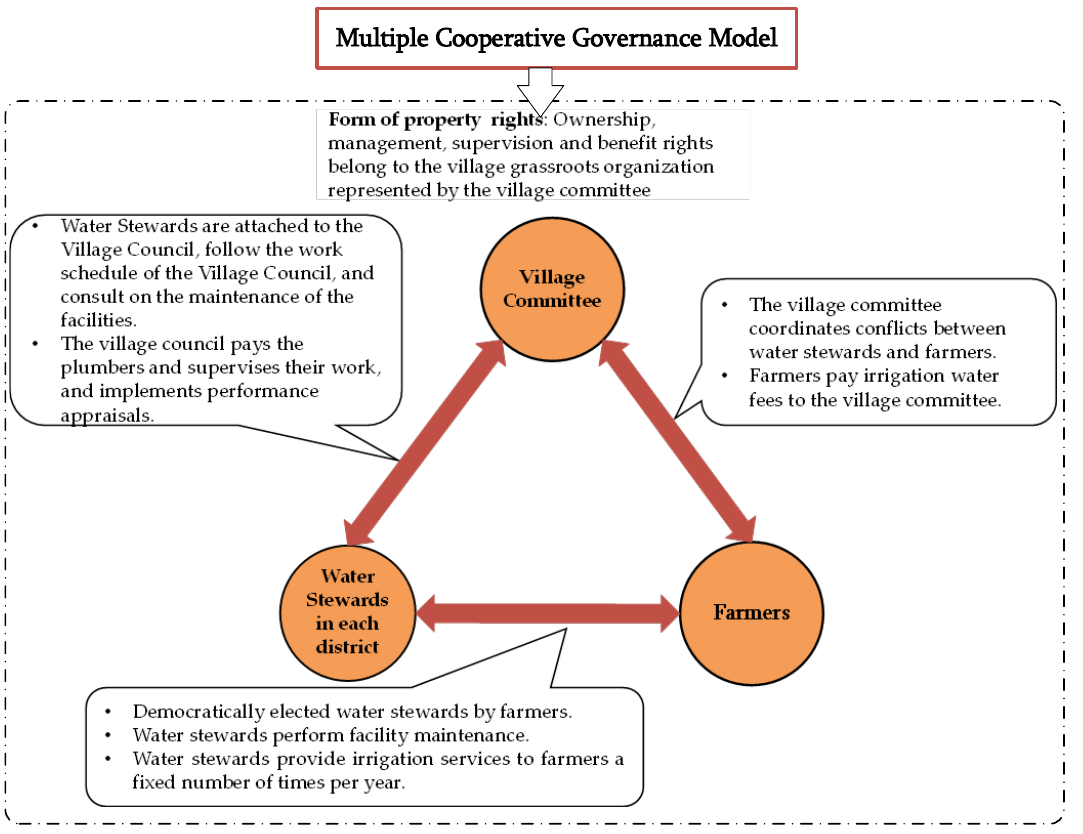
Figure 2. Intrinsic governance logic diagram of the multiple governance model.